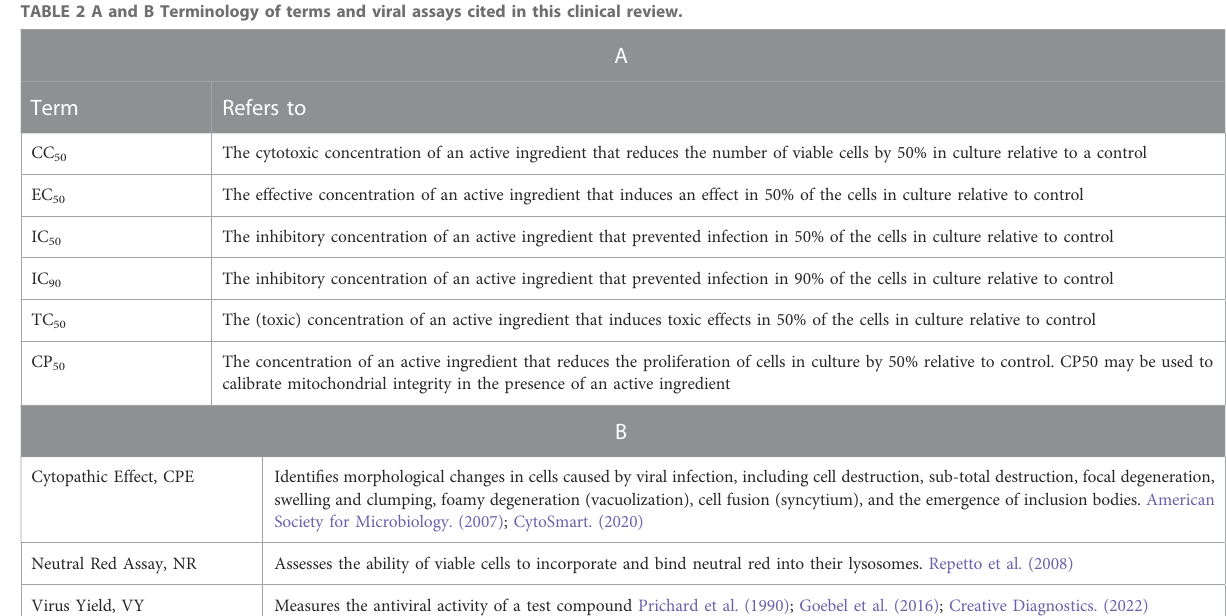
TABLE 2 A and B Terminology of terms and viral assays cited in this clinical review.